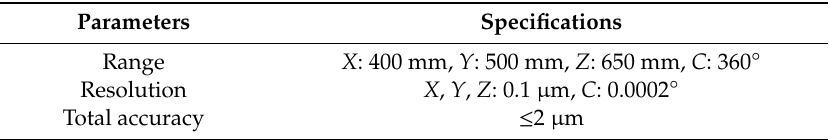
Table 3. Parameters of four-coordinate measuring machine.